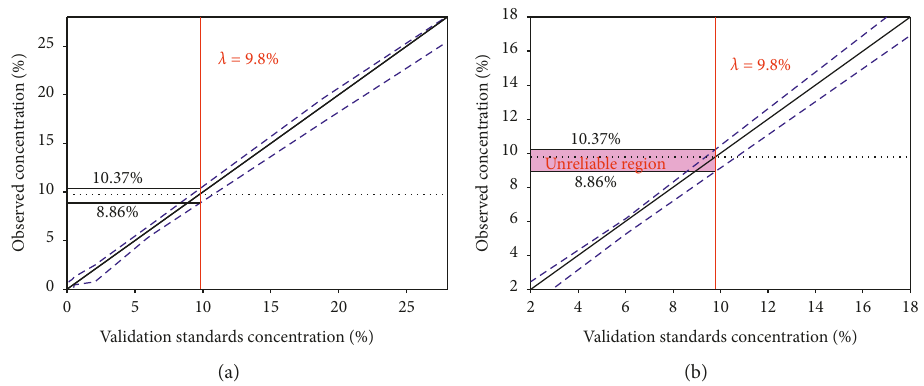
Figure 6: (a) The unreliability graph of tanshinoneII A . (b) The unreliable region estimated around the specification limit of tanshinoneII A in tanshinone extract. Blue dashed lines are the 66.7% β -content, 90% c -confidence tolerance intervals; the diagonal continuous line is the identity line y x ; the red vertical straight line and the black horizontal dashed line are the API specification limits; the shaded region (cid:31) corresponds to the unreliable